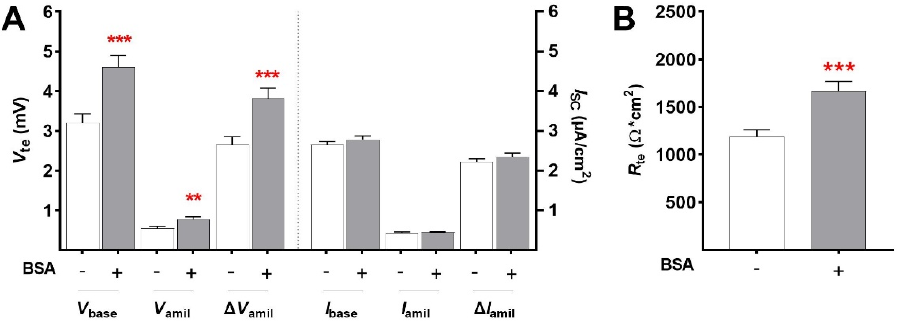
Figure 1. BSA increases epithelial Na + transport after 24 h. FDLE cells were cultured in MEM and stimulated with BSA (1.0 g/L) for 24 h. Data are displayed as mean + SEM. ( A ) BSA significantly increased V base , V amil , and Δ V amil (n = 55–56; ** p < 0.01; *** p < 0.001 by t -test). ( B ) BSA further significantly elevated R te in FDLE cells (*** p < 0.001 by t -test).